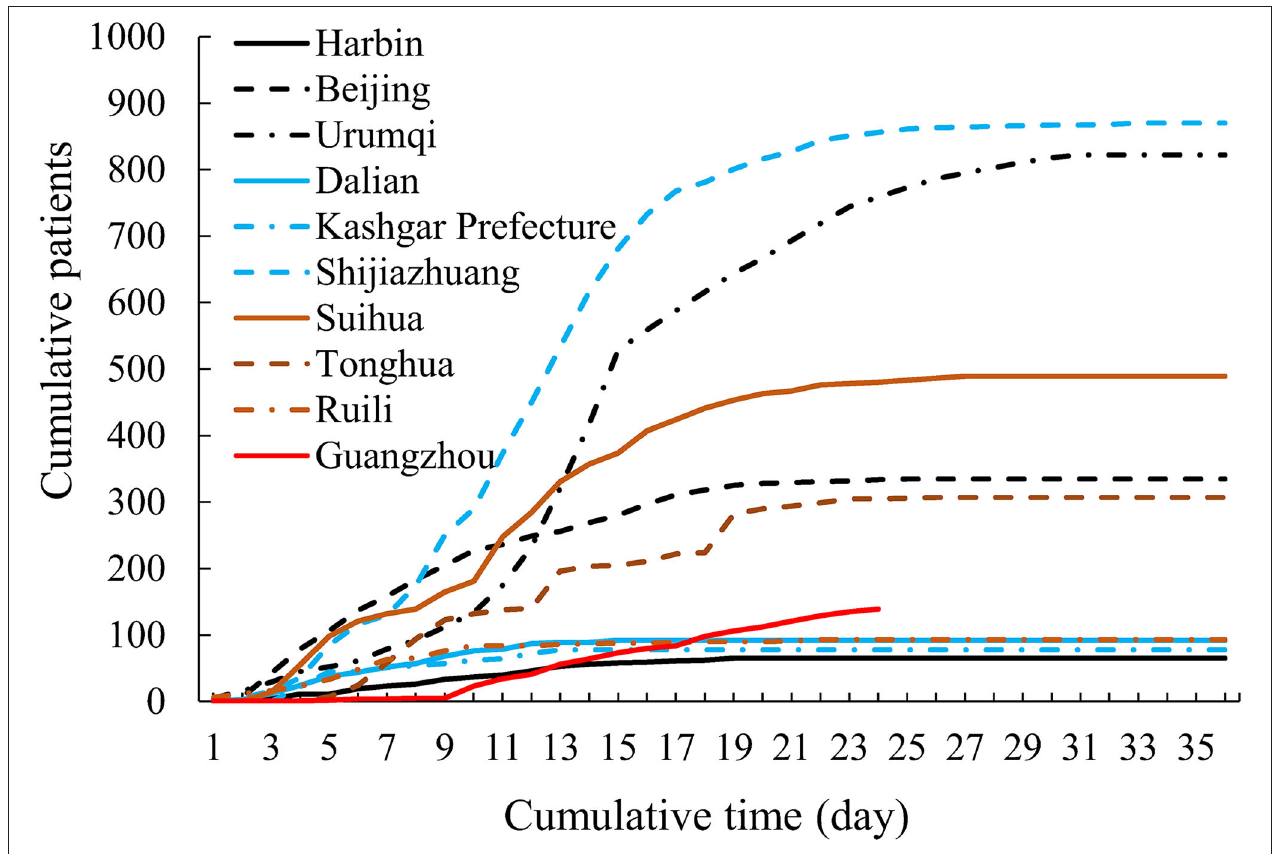
FIGURE 1 | The epidemic curve of new indigenous outbreaks in 10 cities with the largest number of patients in Chinese mainland.